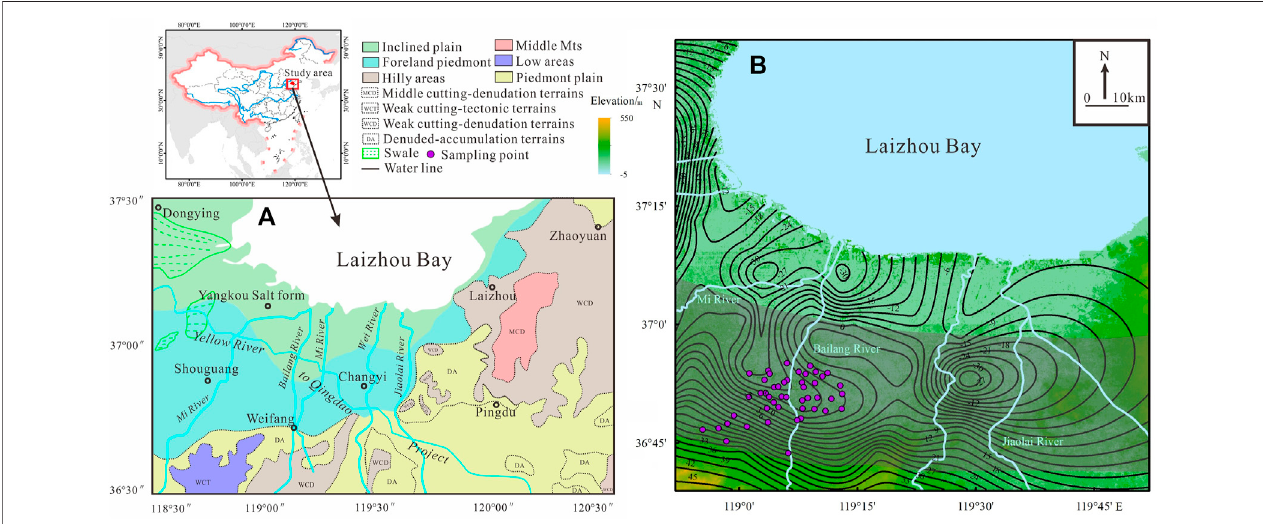
FIGURE 1 | (A) Location map of the study area. Also shown are the landform types in the southern Laizhou Bay. (B) The locations of the sampling site and groundwaterlevelinthestudyarea.Theshadedareareferstothesaline-freshwatermixingzone(DEMandDEMdataisderivedfromglobalbathymetricdata,Yangetal., 2021).